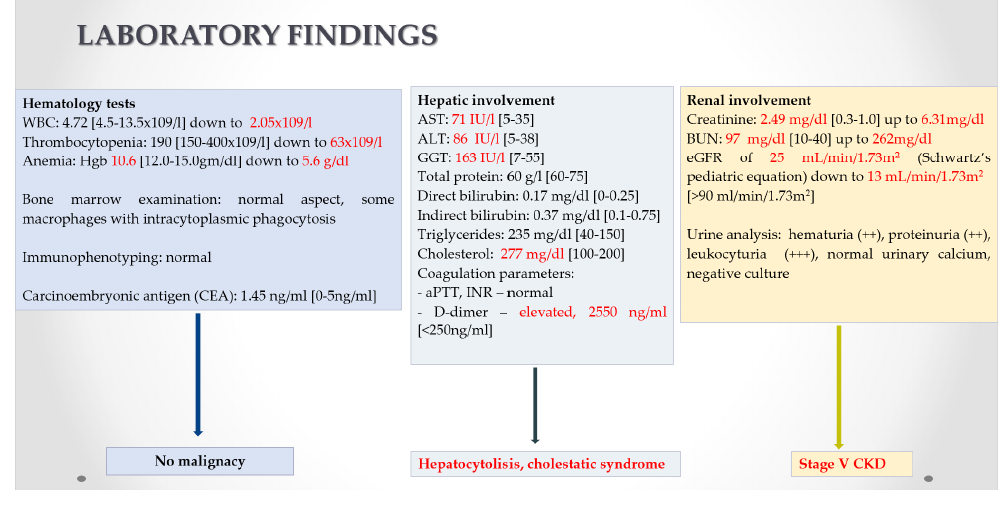
Figure 1. Differential diagnosis at presentation.